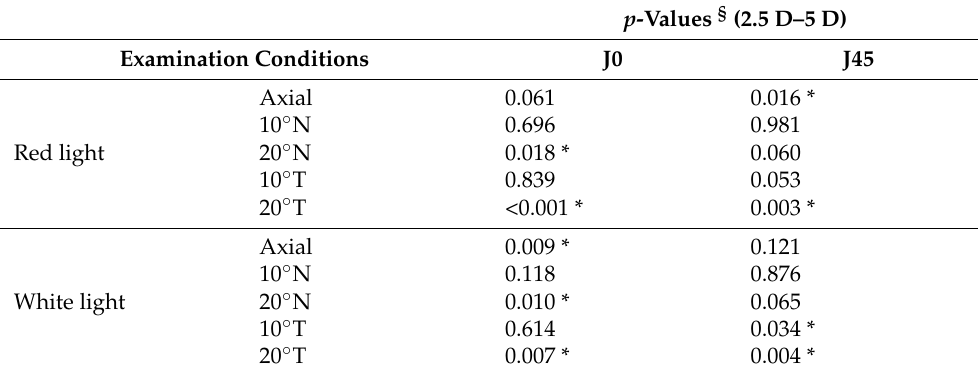
Table 4. Differences of J0 and J45 with accommodation at each examination condition.